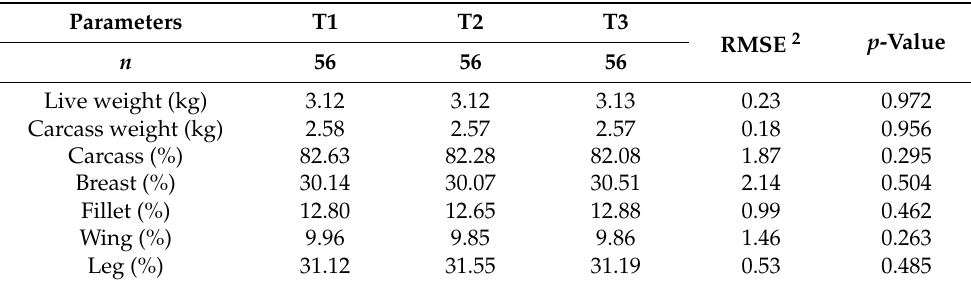
Table 4. Effect of guanidinoacetic acid (GAA) dietary supplementation 1 on carcass composition and carcass cuts.